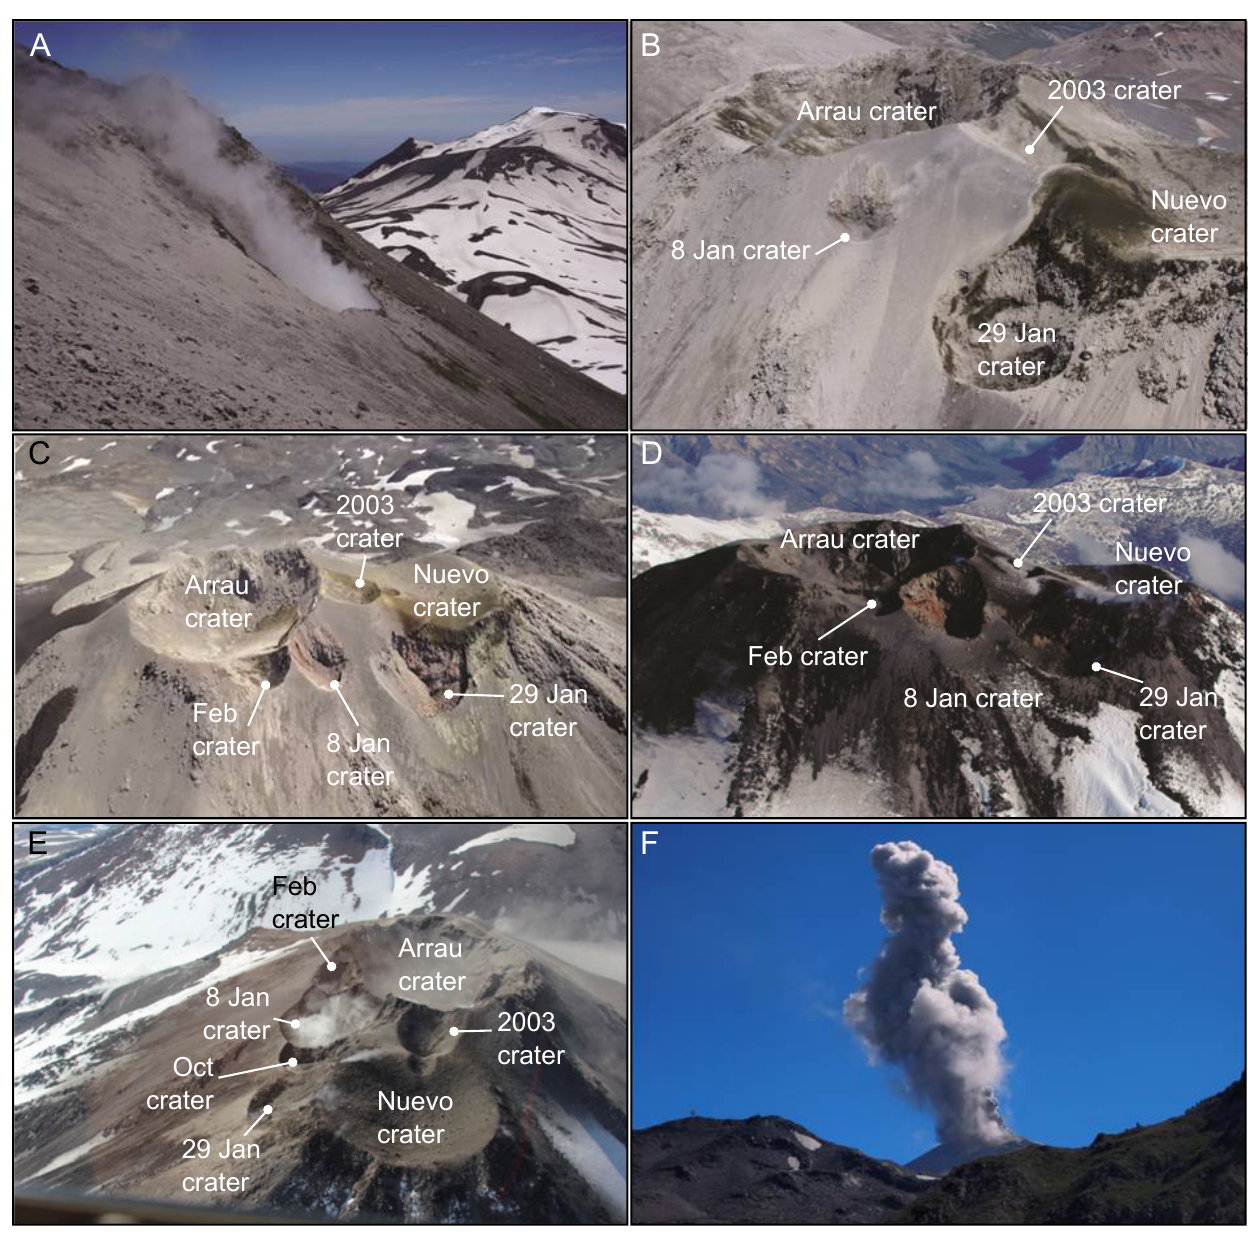
Figure 2: [A] Photograph of the first crater, 30 m across, formed on 8 January 2016. The photograph was taken on 13 January 2016, looking north-east. [B] Aerial photograph taken on 30 January 2016, looking south, showing the first and second craters (formed 29 January 2016). [C] Aerial photograph taken on 11 February 2016, looking south-west, showing the first, second and third craters (formed sometime between 30 January and 11 February 2016). [D] Aerial photograph taken on 9 August 2016, looking south-south-west, showing the growth of the first crater following a comparatively larger eruption that produce a 2000 m high ash plume. [E] Aerial photo- graph taken on 22 October 2016, looking south-east, showing the first, second, third and fourth craters (formed sometime in October 2016). [F] Photograph of an eruption taken on the 2 February